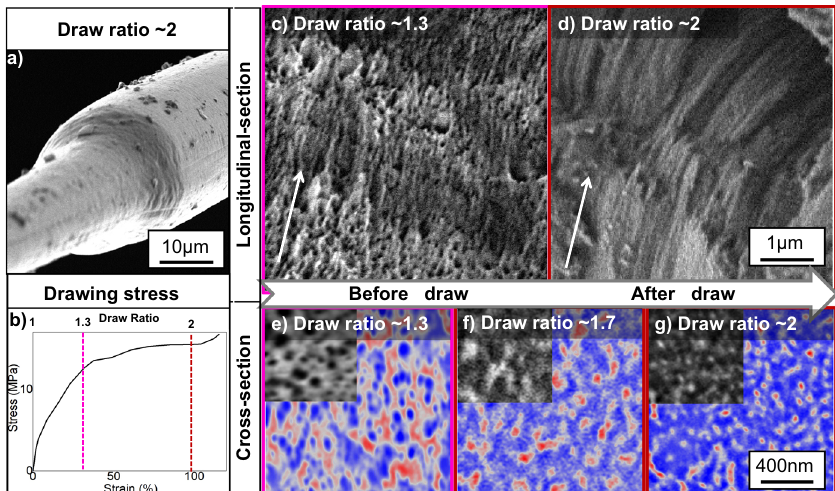
development, the fi bre longitudinal axis is marked by a white arrow in c , d . SEM images are taken in backscattered mode, with contrast corresponding to local density 64 . Red in the colour coded images represent areas of higher density and blue represent areas of lower density alongside